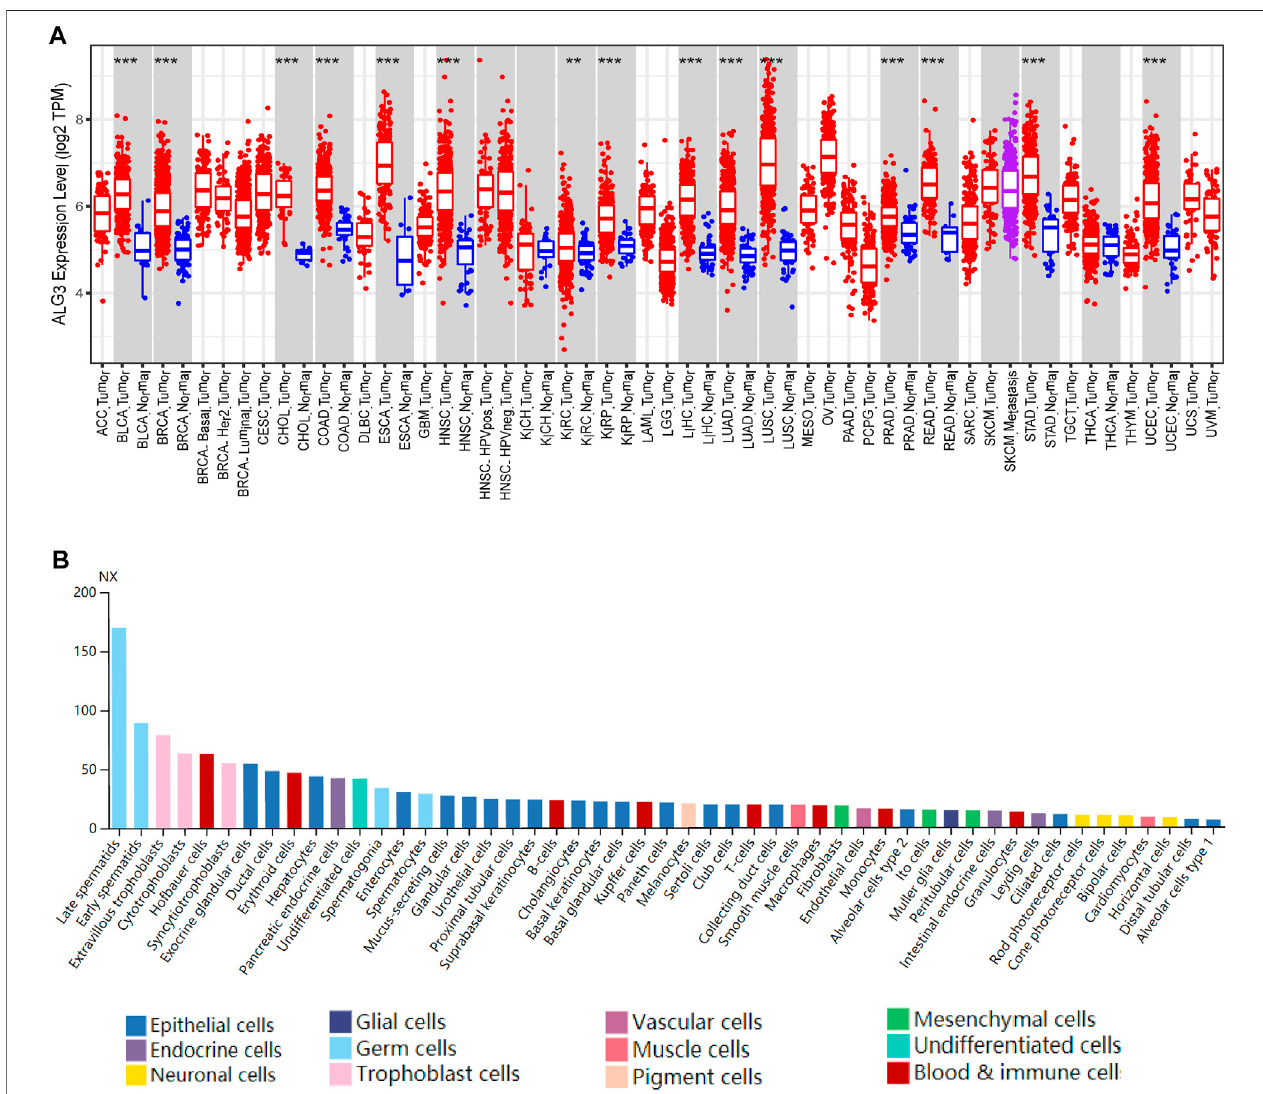
FIGURE 1 | Expression of ALG3 in different cancer types. (A) ALG3 mRNA expression levels across different cancer types in the TIMER database. (B) ALG3 expression in single cell type lines analyzed by HPA. (** p < 0.01 and *** p < 0.001) ACC, adrenocortical carcinoma; BLCA, bladder urothelial carcinoma; BRCA, breast invasive carcinoma; CESC, cervical squamous cell carcinoma; CHOL, cholangiocarcinoma; COAD, colon adenocarcinoma; DLBCL, lymphoid neoplasm diffuse large B-cell lymphoma; ESCA, esophageal carcinoma; GBM, glioblastoma multiforme; HNSC, head and neck squamous cell carcinoma; KICH, kidney chromophobe carcinoma; KIRC, clear cell renal cell carcinoma; KIRP, kidney renal papillary cell carcinoma; LAML, acute myeloid leukemia; LGG, brain lower grade glioma; LIHC, liver hepatocellularcarcinoma;LUAD,lungadenocarcinoma;LUSC, lungsquamouscellcarcinoma;MESO,mesothelioma;OV,ovarianserouscystadenocarcinoma;PAAD, pancreatic adenocarcinoma; PRAD, prostate adenocarcinoma; PCPG, pheochromocytoma and paraganglioma; READ, rectal adenocarcinoma; SARC, sarcoma; SKCM, skin cutaneous melanoma; STAD, stomach adenocarcinoma; TGCT, testicular germ cell tumor; THCA, thyroid carcinoma; THYM, thymoma; UCEC, uterine endometrial carcinoma; UCS, uterine carcinosarcoma; UVM, uveal melanoma.